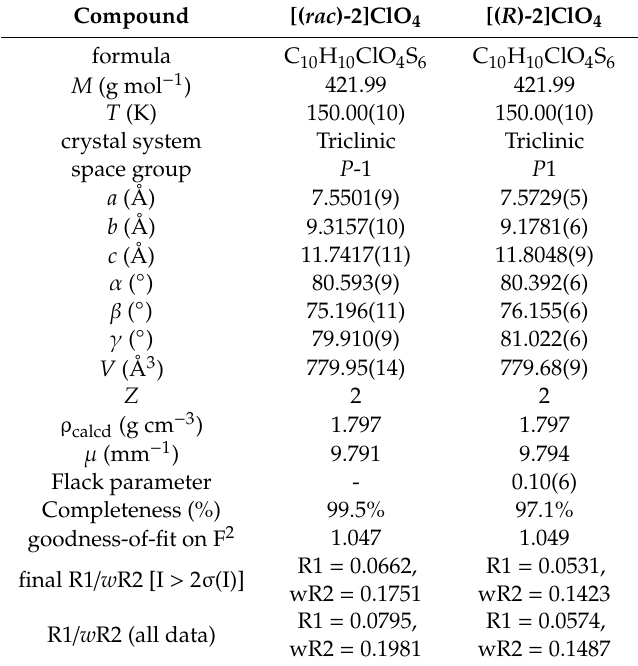
Table 2. Crystal Data for compounds [( rac )- 2 ]ClO 4 and [( R )- 2 ]ClO 4